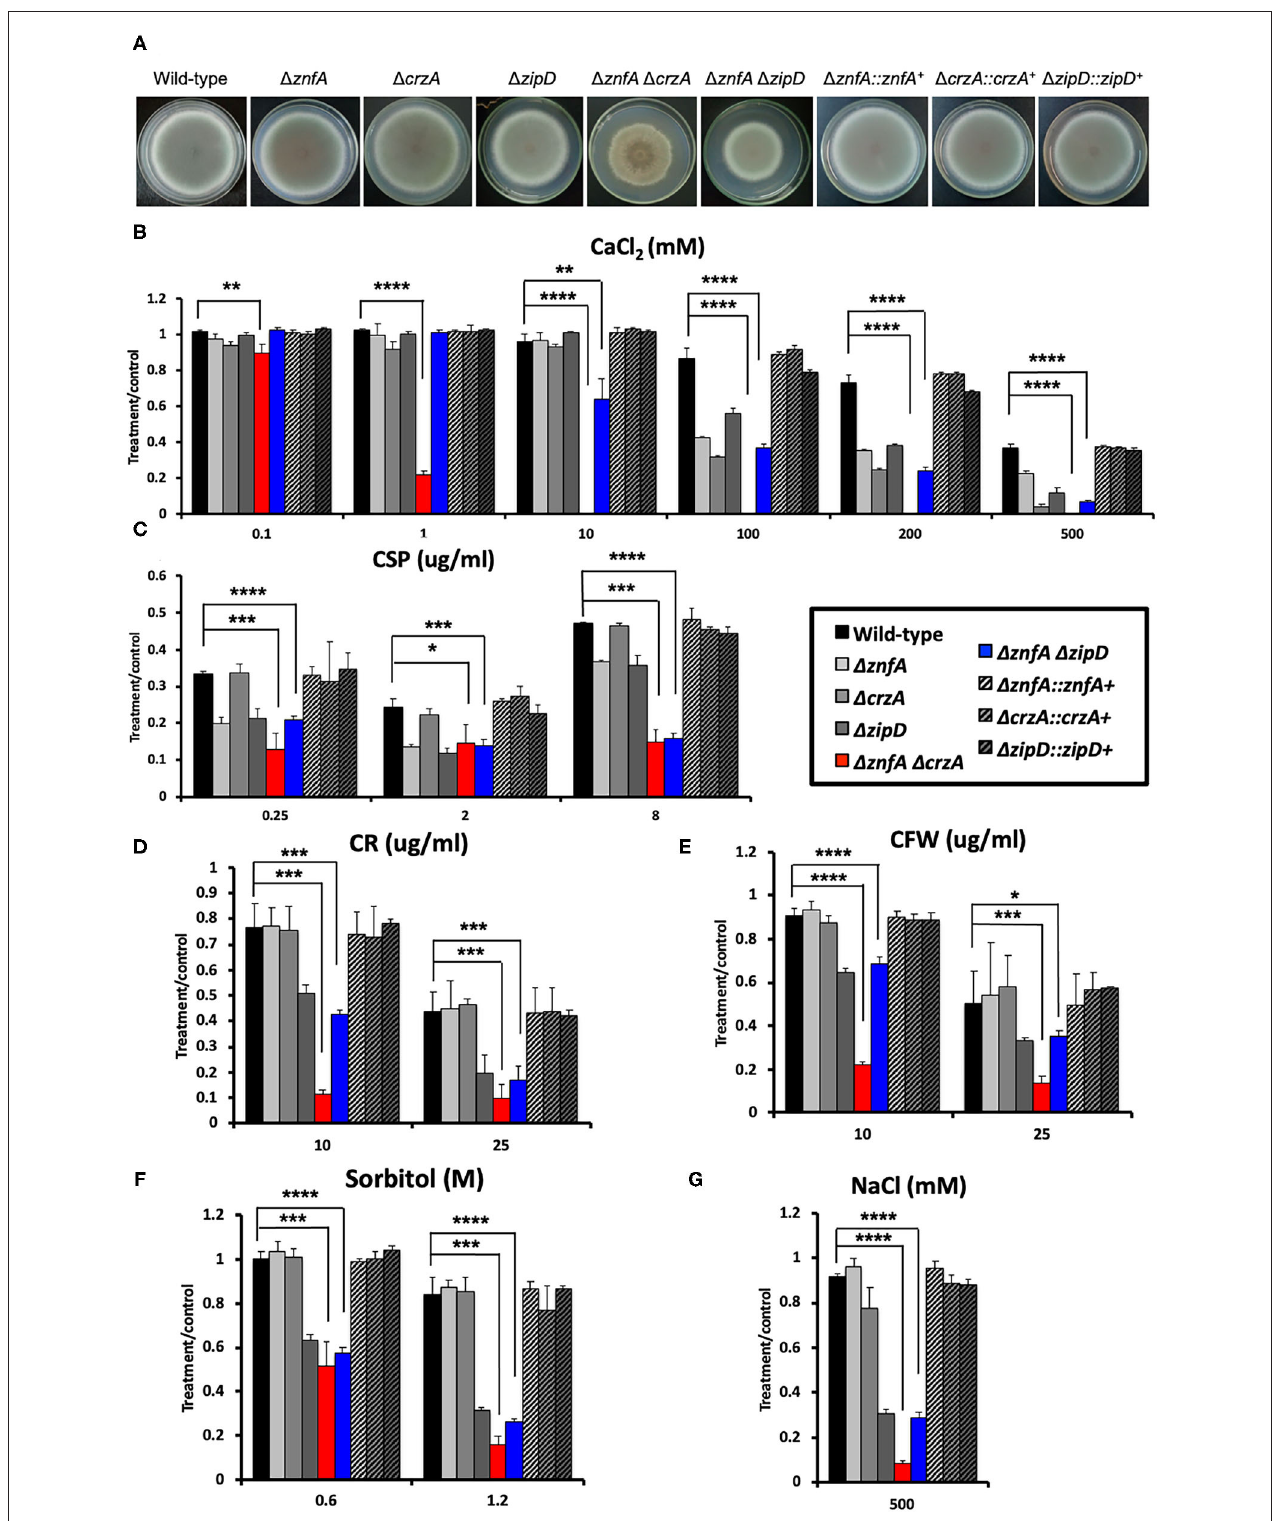
FIGURE 4 | A. fumigatus ZnfA, CrzA and ZipD transcriptions factors collaborate in the response to calcium and caspofungin stresses. (A) Growth phenotypes of the wild-type, 1 znfA , 1 crzA, 1 zipD, 1 znfA 1 crzA, 1 znfA 1 zipD , and corresponding complemented strains grown for 5 days at 37 ◦ C in solid MM. Radial growth determination of aforementioned strains in the presence of increasing concentrations of (B) calcium chloride (CaCl 2 ), ( C) caspofungin (CSP), (D) Congo red (CR), (E) calcofluor white (CFW), (F) sorbitol and (G) sodium chloride (NaCl). Standard deviations represent three biological replicates and statistical analysis was performed using one-tailed, paired t -test (* P < 0.05; ** P < 0.01; *** P < 0.001; **** P < 0.0001).